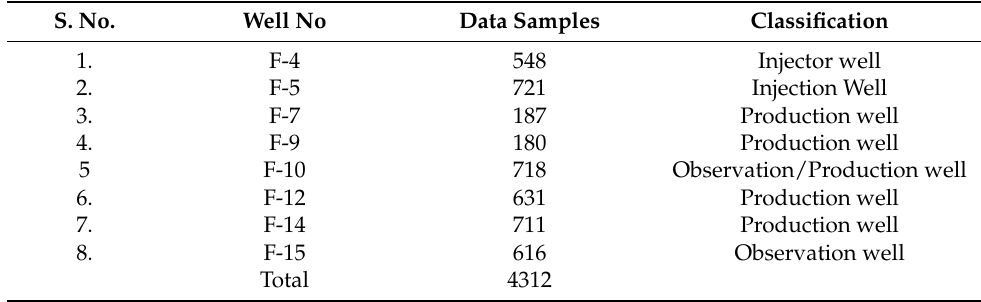
Table 2. Details of data samples extracted from the Final drilling reports of Norwegian wells. S.